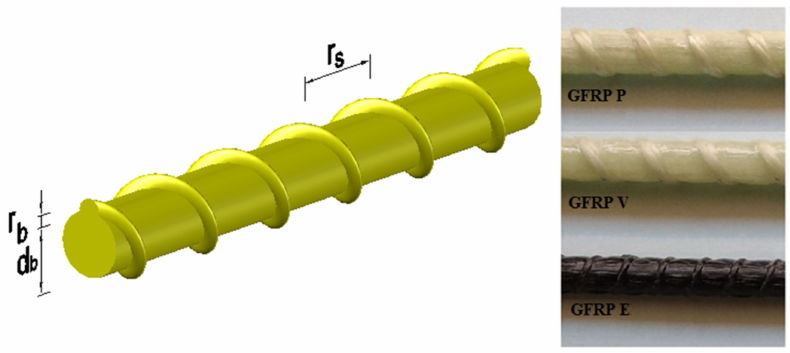
Figure 1. Geometric characteristics of GFRP bars. Table 1. Physical properties and geometric characteristics of GFPR bars manufactured with